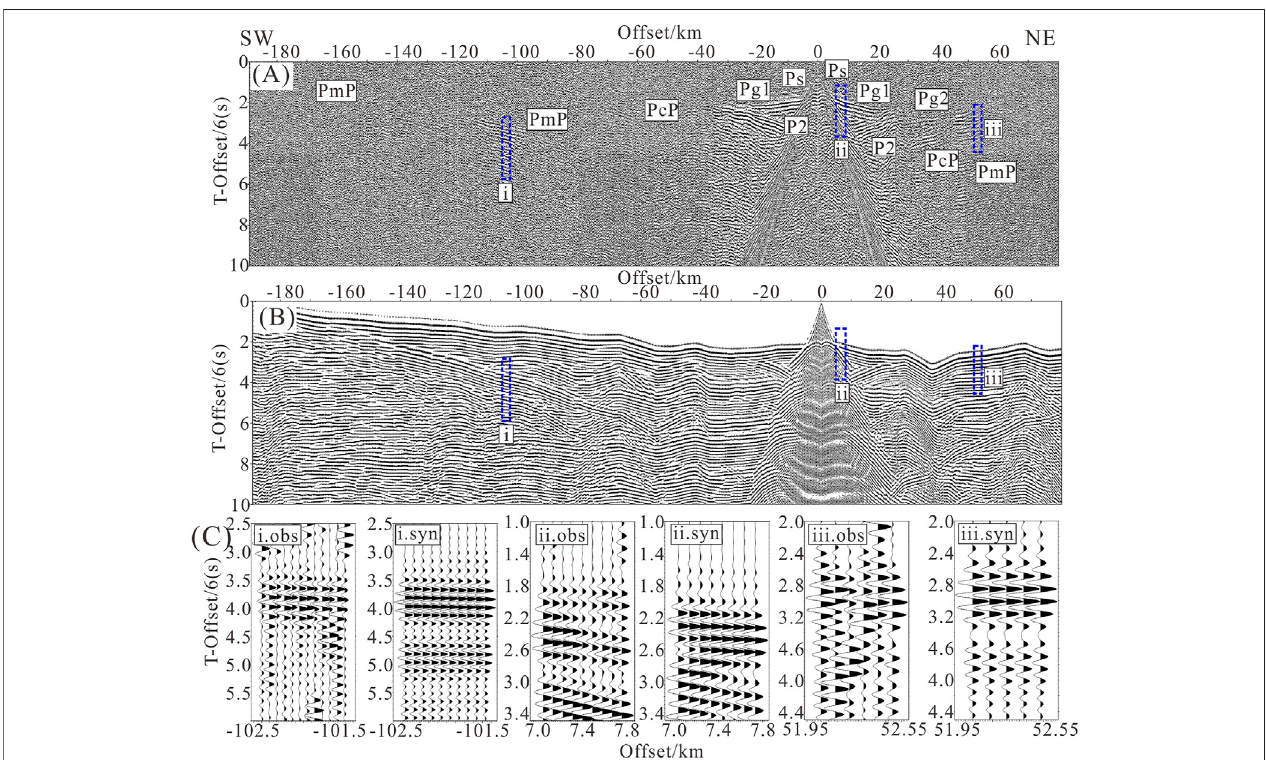
FIGURE 5 | (A) Observed seismograms after pre-processing from the hydrophone of OBS C15 located in the middle of ND-SYS on Line 2016. The blue dashed squares (i, ii, iii) that have relatively higher SNR, are displayed in Figure 5C as a close-up of the observed seismograms. (B) Corresponding synthetic seismograms calculated from theVp model ofLine 2016by using the fi nitedifference modelingcode from the Seismic Unix package (Stockwell, 1999).The trace spacing was100 m, thefrequencyofthesourcewaveletcenteredaround5 Hz.Afreeboundaryconditionwasgiventothetopofthemodel,andtheotherthreeboundariesweresetas absorbingboundaryconditions.Nonoisewasaddedtothesyntheticseismograms.Thebluedashedsquares(i,ii,iii)arelocatedatthesamepositionasFigure5 (A) and are displayed in Figure 5 (C) asaclose-up ofthesynthetic seismograms. (C) Theclose-up image ofthesquaresi, ii,iiiinFigure 5 (A,B) ,and they aredisplayed withagain and fi lter proportional to offset. All fi gures have the same reduced velocity (6 km/s).